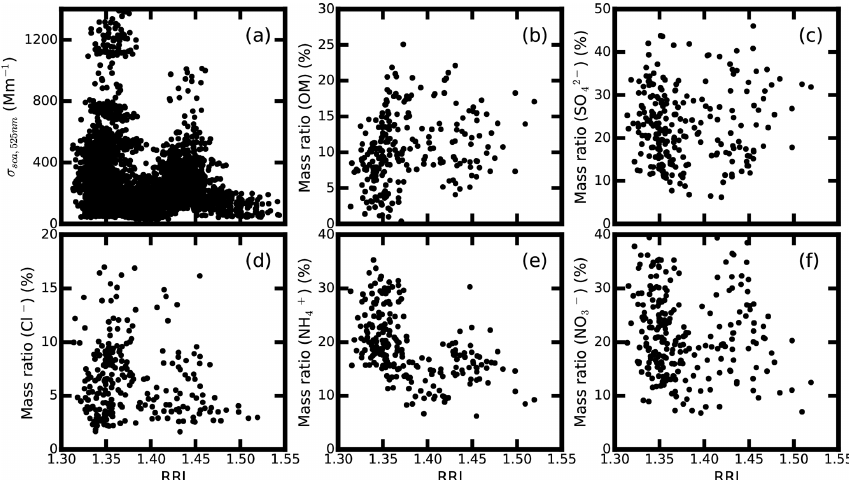
Figure 7. Comparison of the measured RRI at 300nm with the measured (a) σ sca at 525nm; mass fraction of (b) OM, (c) SO 2 − (e) NH + and (f) NO − . 4 3